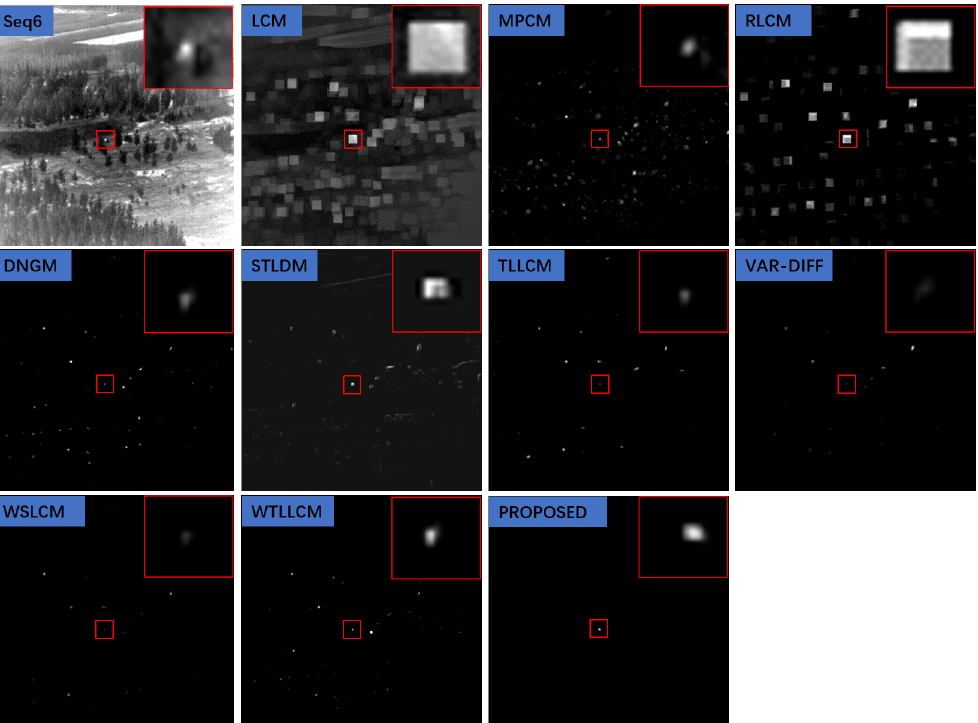
Figure A5. Detection results of one frame in data6. The first sub-image is the original image, and the rest are the detection results of each algorithm.